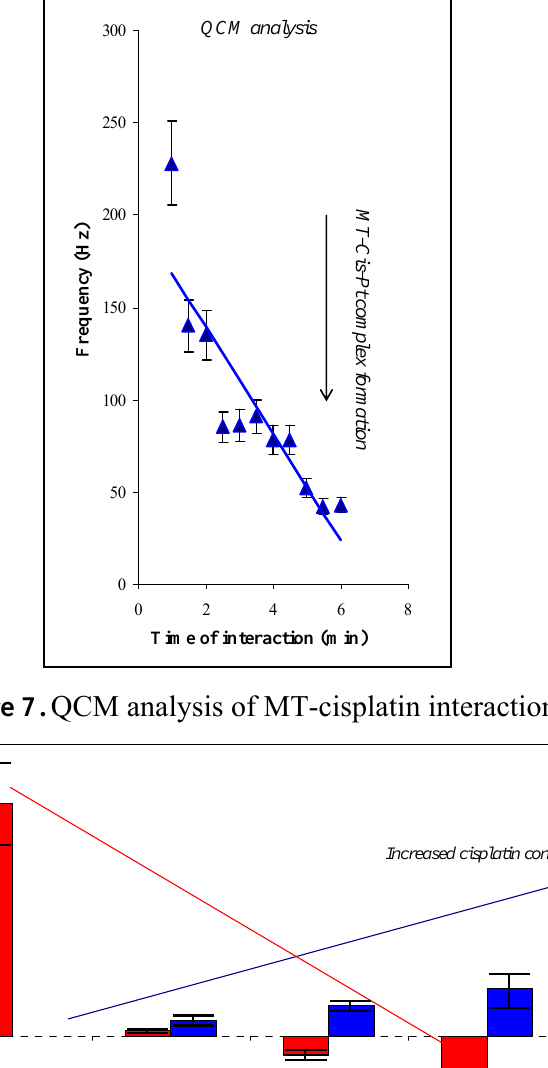
Figure 6. QCM analysis of MT-cisplatin interactions (various times of interaction (MT: 10 µg mL -1 , cisplatin: 100 µg mL -1 ), n = 5.